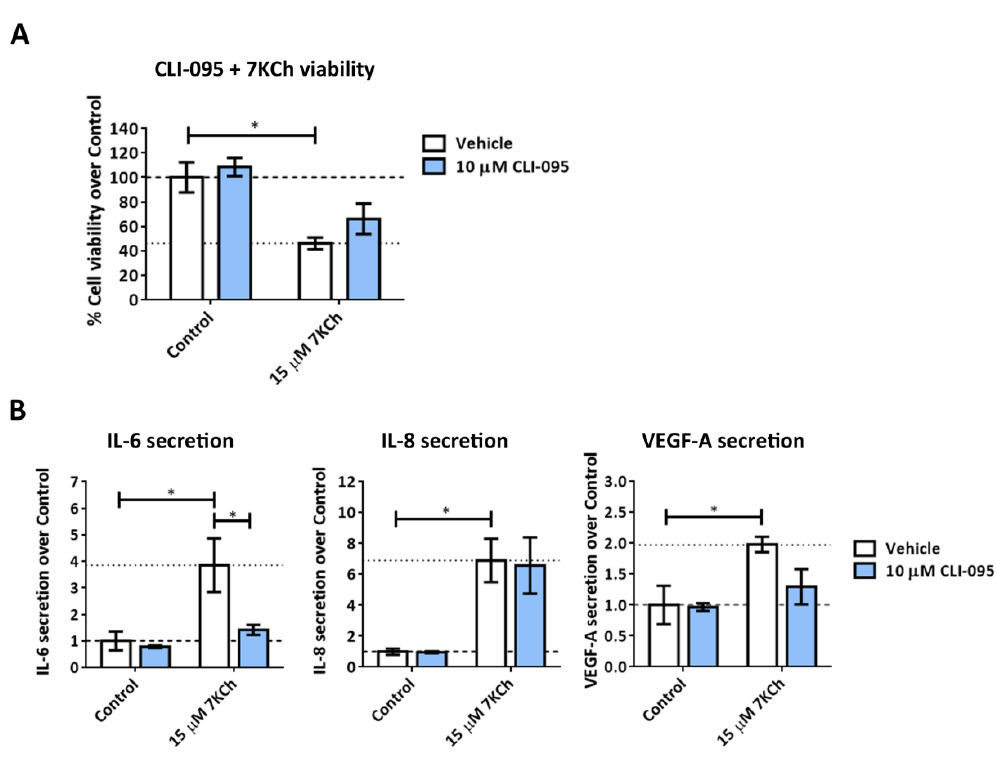
Figure 4. Effect of TLR4 inhibition with CLI-095 on 7KCh-induced toxicity and inflammation. ( A ) Cell viability determined by MTS assay in mRPE cells treated with 15 μM 7KCh and 10 μM CLI-095 for 24 h. ( B ) Secreted levels of IL-6, IL-8 and VEGF-A in mRPE cells exposed to 15 μM 7KCh and 10 μM CLI-095 for 48 h and measured with ELISA. CLI-095 was added with a pretreatment of 2 h with respect to 7KCh. The vehicle group in the graphs represents the control (control-vehicle) and the 7KCh (7KCh-vehicle) treatment. Data are represented as mean ± SEM of at least three different experiments. The dashed and dotted lines are a guidance mark of control and 7KCh value, respectively. ANOVA test was used for statistical analysis followed by Sidak post hoc test. * p < 0.05.